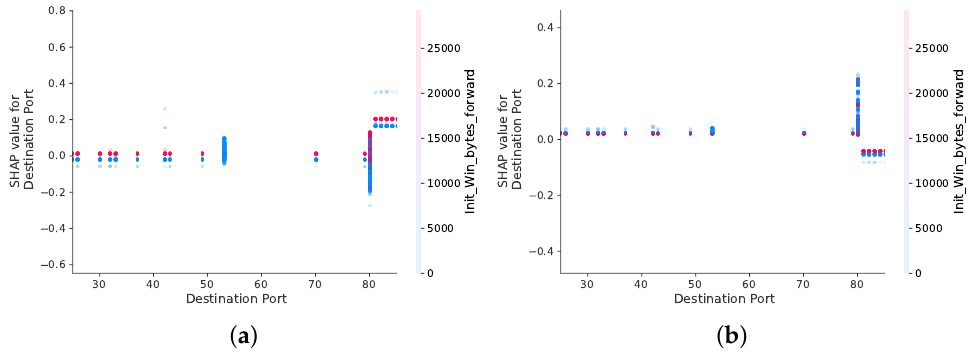
Figure 11. Init Win bytes forward/Destination Port interaction plots. ( a ) Init Win bytes forward/ Destination Port interaction for benign traffic; ( b ) Init Win bytes forward/Destination Port interaction for DDoS